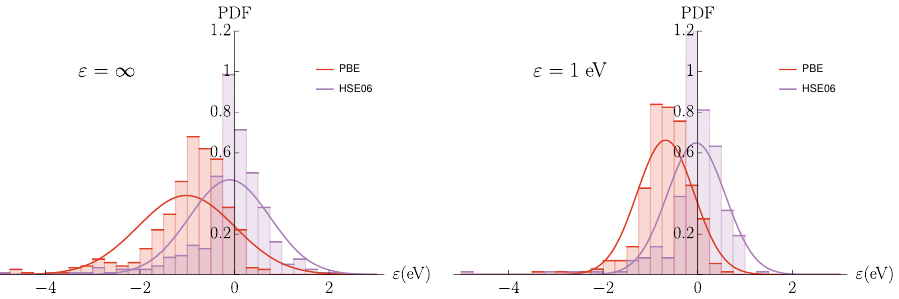
Figure 9. Histograms showing the distribution of errors before and after introducing similarity ( left , and right panel for (cid:101) = ∞ and (cid:101) = 1 eV, respectively), for PBE (red) and HSE06 (blue). The normal distributions using the mean and standard deviation of these error distributions are shown as